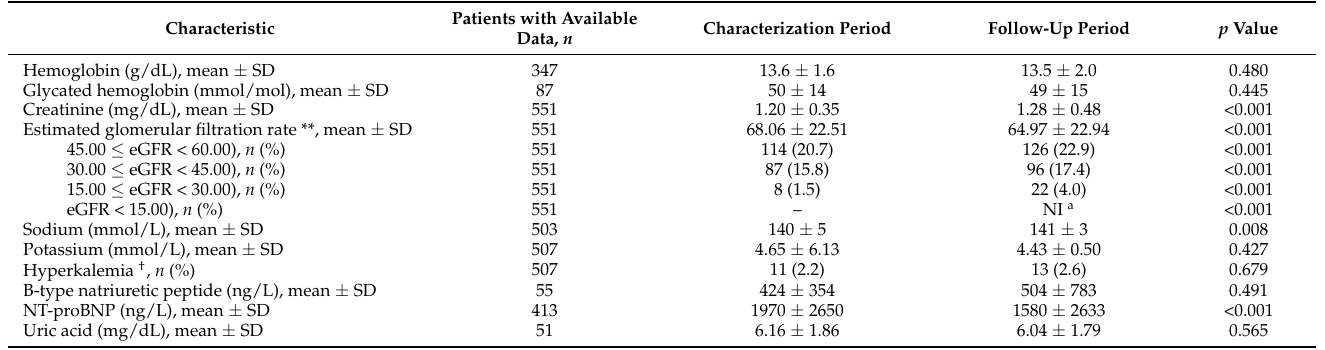
Table 4. Routine laboratory test results in patients with available data during characterization and follow-up periods